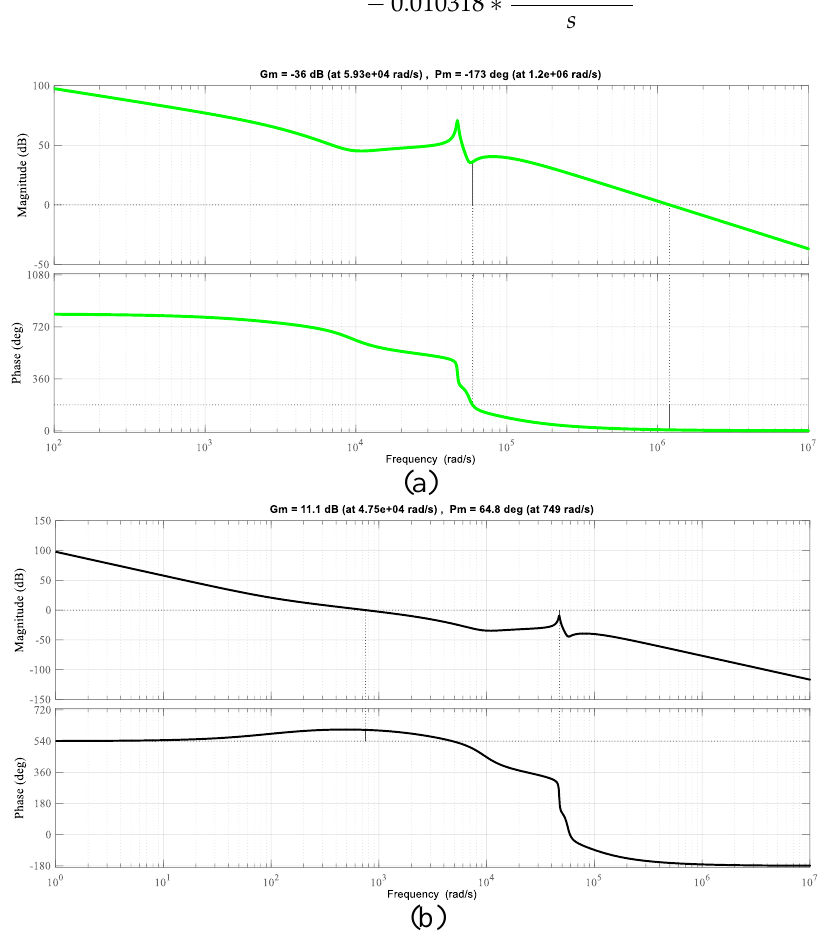
Figure A1. The bode diagram: ( a ) before compensating; ( b ) after